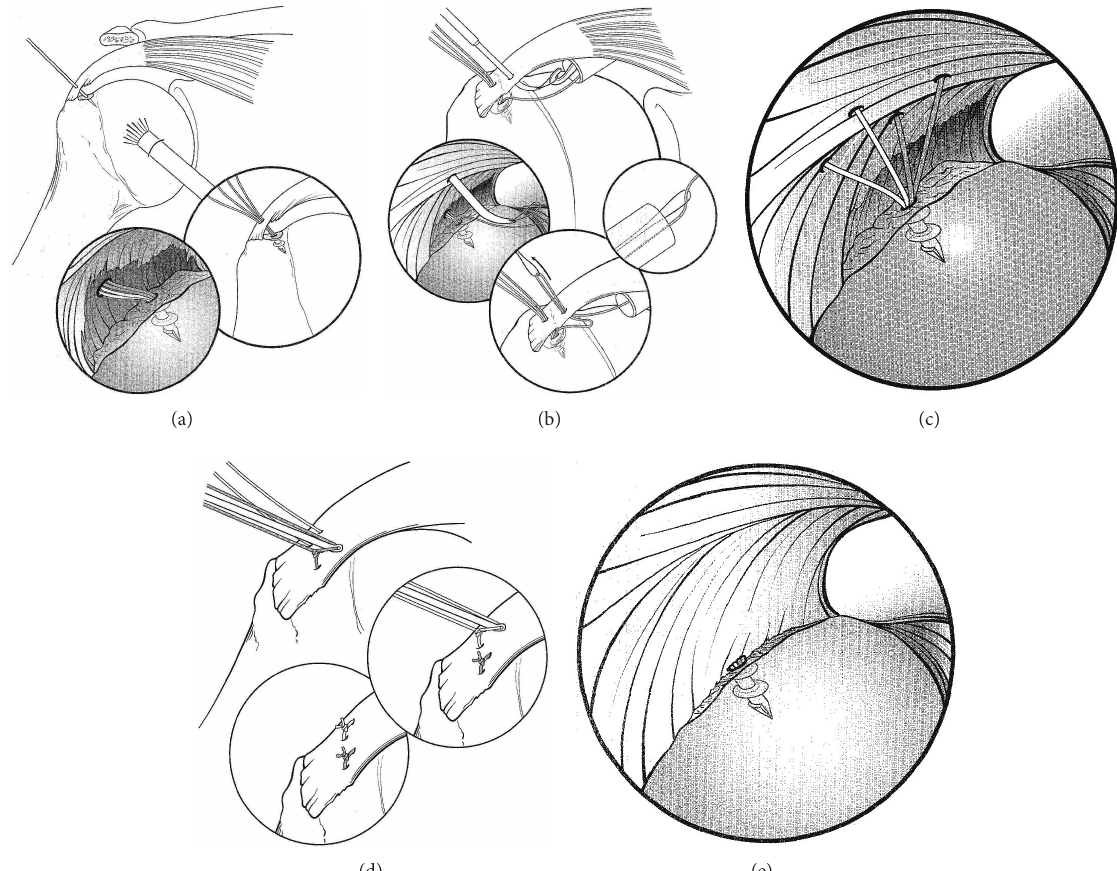
Figure 2: Transtendon repair of a partial thickness articular surface rotator cuff tear. (a) An 18-gauge needle is used to localize the trajectory of the proposed suture anchor. The suture anchor inserted transtendon into the medial aspect of the bone bed. (b) A suture passer is used to shuttle sutures through the intact portion of the rotator cuff. (c) Four suture limbs have been shuttled through the tendon, creating two mattress stitches. (d) The mattress stitches are tied in the subacromial space, reducing the tendon to the bone. (e) After tying all of the sutures, the arthroscope is placed back in the glenohumeral joint to visualize the repair and the reduction of the tendon to the bone (adapted and reprinted from [7] with permission from